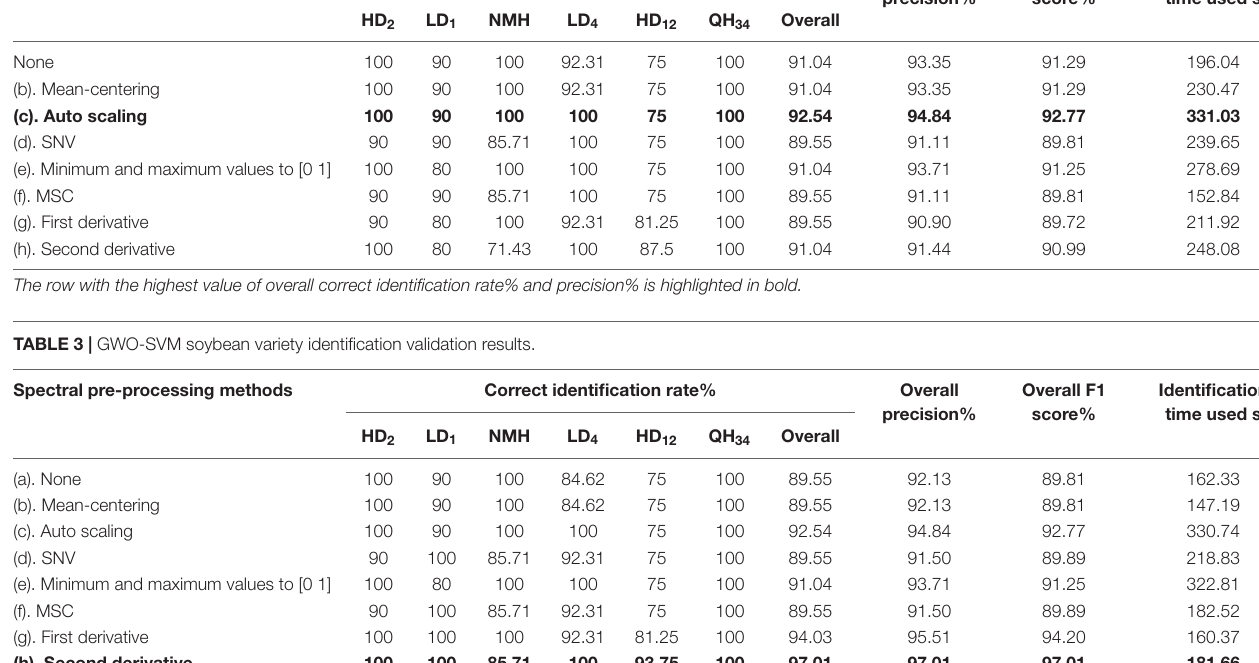
TABLE 2 | PSO-SVM soybean variety identification validation results. Spectral pre-processing methods